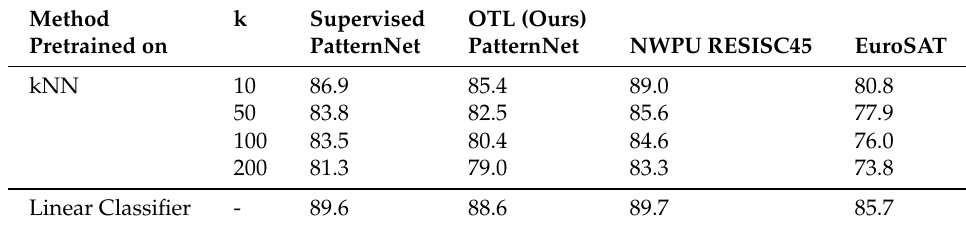
Table 8. SIRI WHU google.